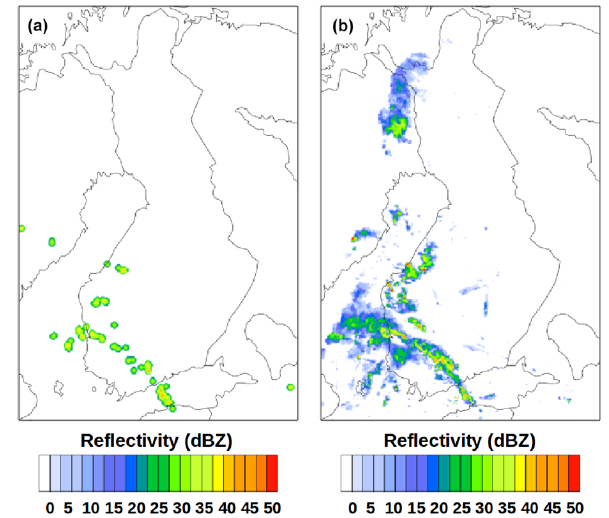
Figure 8. Reflectivity field simulated from lightning data alone (left) and, for verification, from radar data alone (right) 30 July 2014 at 16:00UTC. The reflectivity color scale is shown below